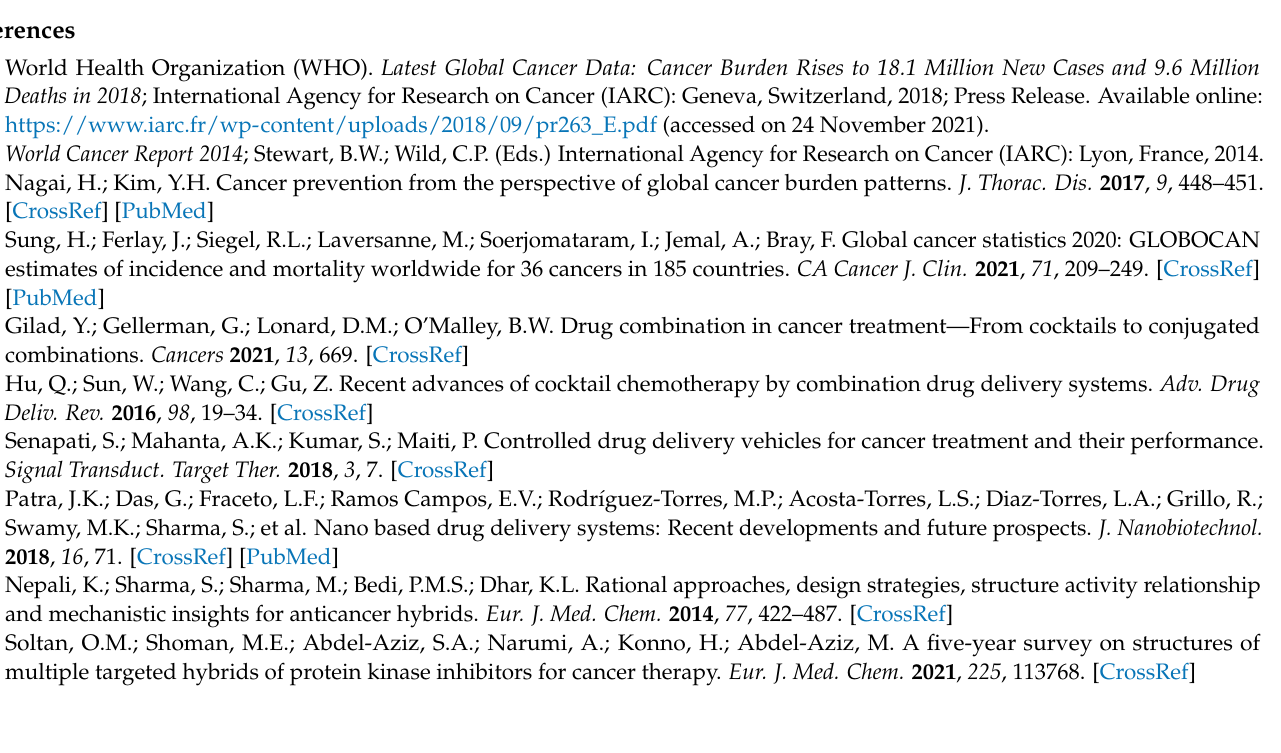
Figure S3: 1 H NMR of 5-FUDA . Figure S4: 13 C NMR of 5-FUDA . Figure S5: DEPT of 5-FUDA . Figure S6: 19 F NMR of 5-FUDA . Figure S7: FT-IR of 5-FUDA . Figure S8: MALDI-TOF MS of 5-FUDA . Figure S9: 1 H NMR of 7-POC . Figure S10: 13 C NMR of 7-POC . Figure S11: APT of 7-POC . Figure S12: FT-IR of 7-POC . Figure S13: 1 H NMR of CP-1 . Figure S14: 13 C NMR of CP-1 . Figure S15: DEPT of CP-1 . Figure S16: 19 F NMR of CP-1 . Figure S17: FT-IR of CP-1 . Figure S18: MALDI-TOF MS of CP-1 . Figure S19: 1 H NMR of 4-POC . Figure S20: 13 C NMR of 4-POC . Figure S21: APT of 4-POC . Figure S22: FT-IR of 4-POC . Figure S23: 1 H NMR of CP-2 . Figure S24: 13 C NMR of CP-2 . Figure S25: DEPT of CP-2 . Figure S26: 19 F NMR of CP-2 . Figure S27: FT-IR of CP-2 . Figure S28: MALDI-TOF MS of CP-2 . Figure S29: Microscopic images (magnification 10 × ) of PANC-1 cells in MTT